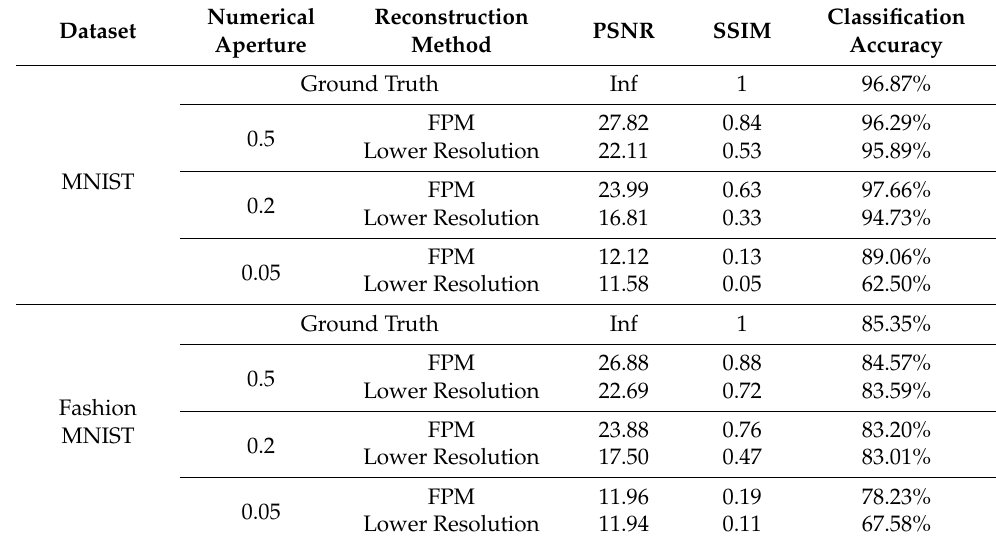
Table 2. PSNR, SSIM, and classification accuracy for MNIST and